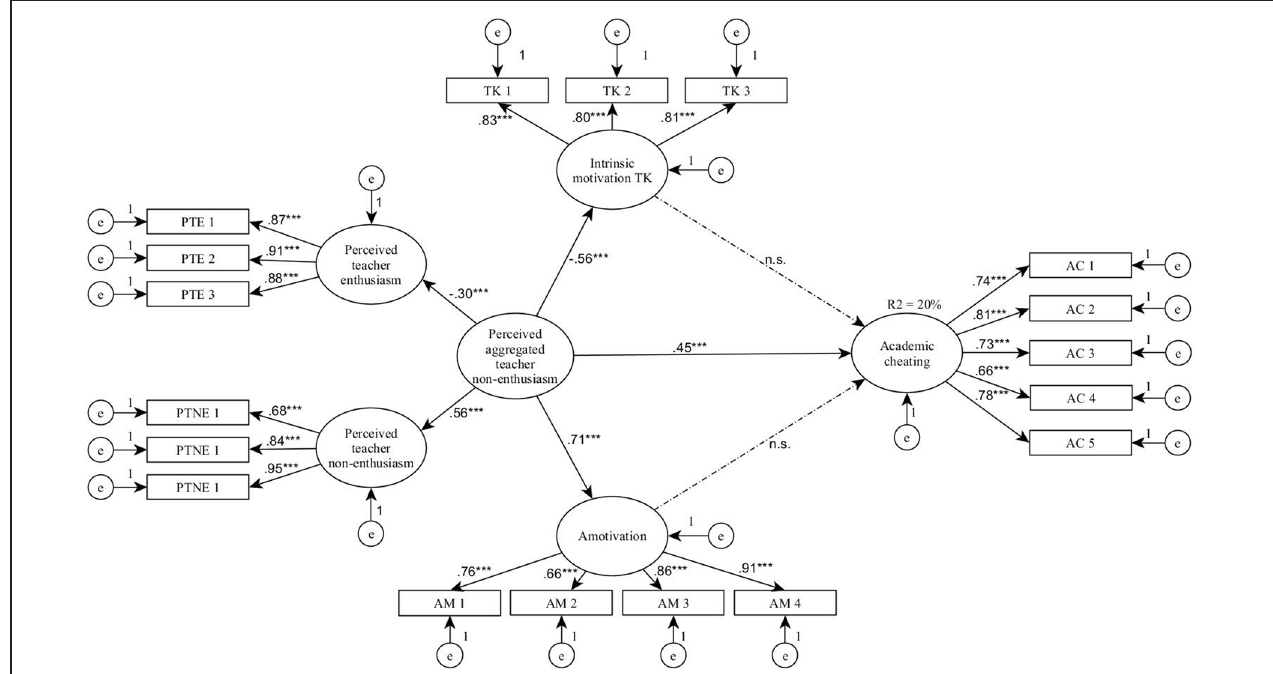
FIGURE 1 | Results of the structural equation modeling. Statistical significance: ∗∗∗ p < 0.001; n.s., not significant result; TK, to-know; AM, amotivation; PTE, perceived teacher enthusiasm; PTNE, perceived teacher non-enthusiasm; AC, academic cheating.